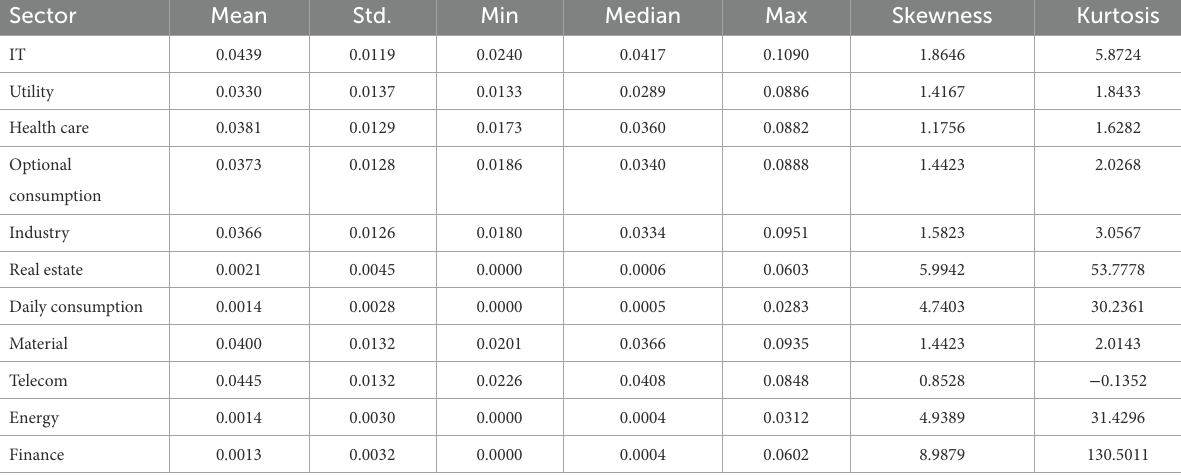
TABLE 2 Descriptive statistics of conditional volatility of 11 sectors.